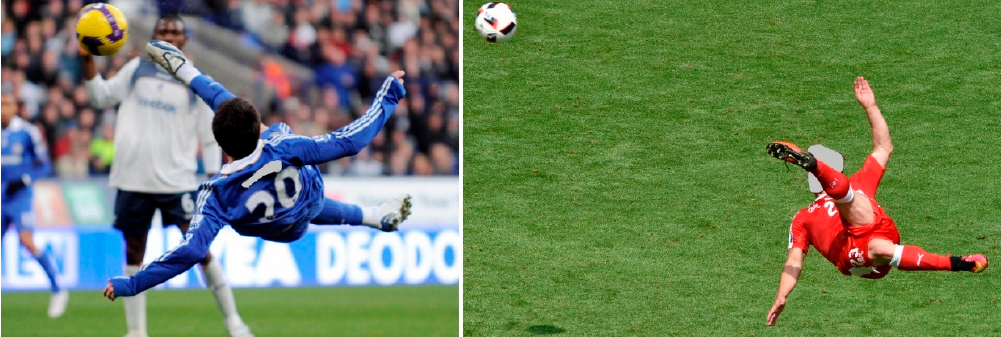
Figure 1. Jumping side volley—a flying techniques for defeating goalies.